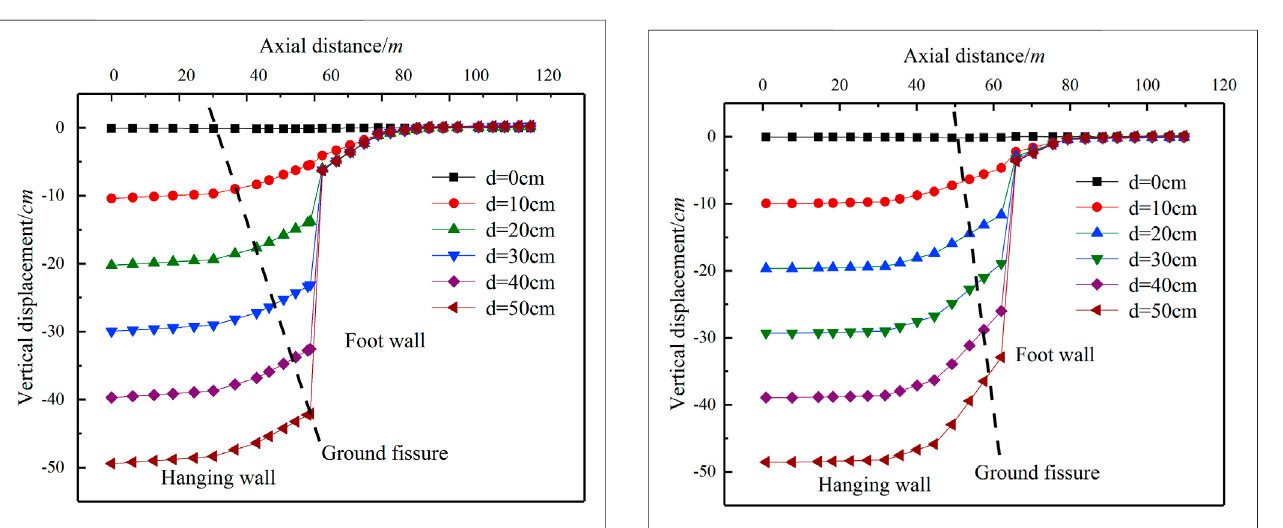
FIGURE 8 | Structural deformation curve of underground utility tunnel obliquely crossing the ground fi ssure (inclination 90 ° ).